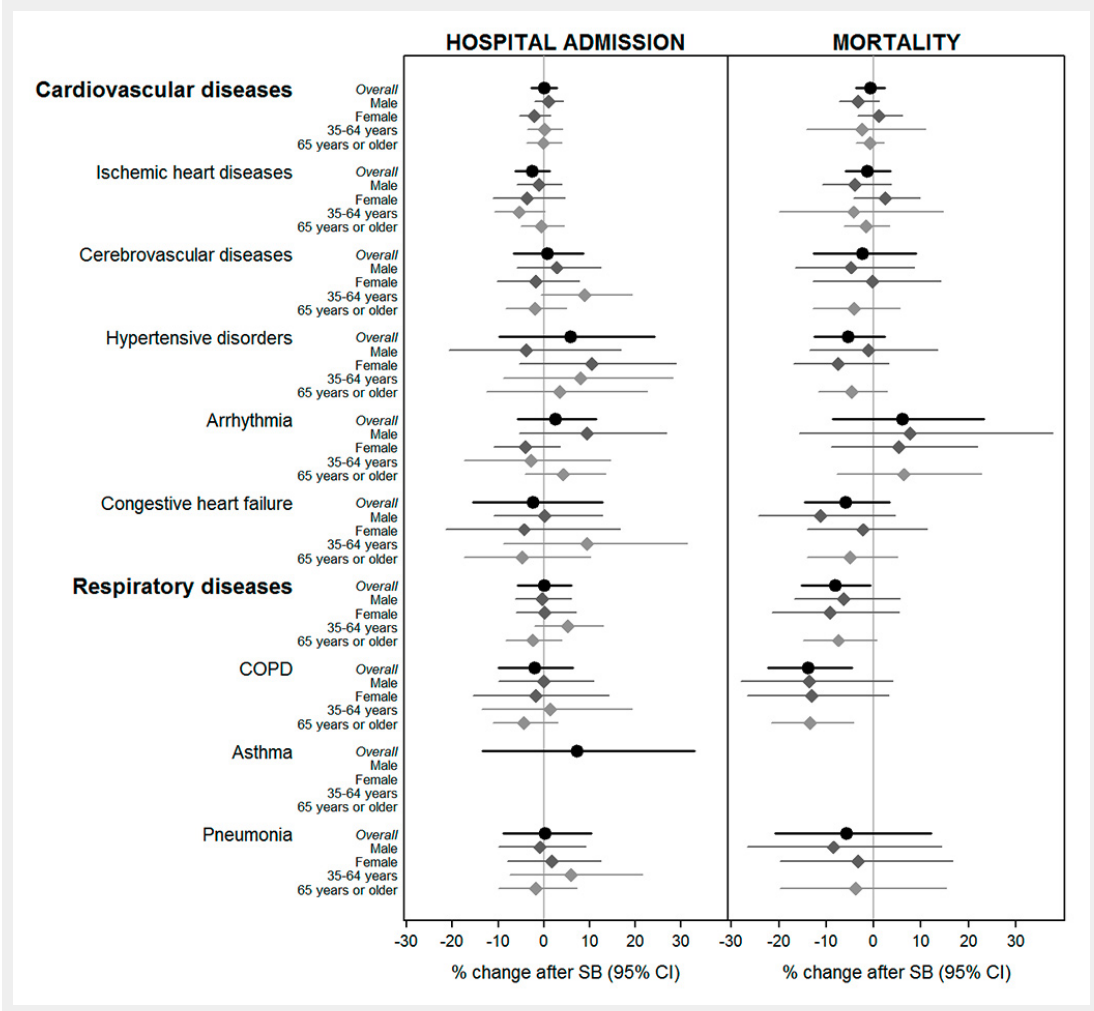
Figure 2 Gender- and age-specific estimates of percentage (and 95% confidence intervals, CIs) change in hospital admissions and mortality in adults (≥35 years old) by the main groups of causes after the introduction of the smoking ban (data restricted to the periods 2 years before and 2 years after the introduction of the smoking ban in each canton). COPD = chronic obstructive pulmonary disease; SB = smoking ban Hospital admissions: Canton Aargau was excluded from the meta-analysis of cardiovascular diseases, ischaemic heart disease, cerebrovascular diseases; Canton Bern was excluded from the meta-analysis of hypertensive disorders, arrhythmia, congestive heart